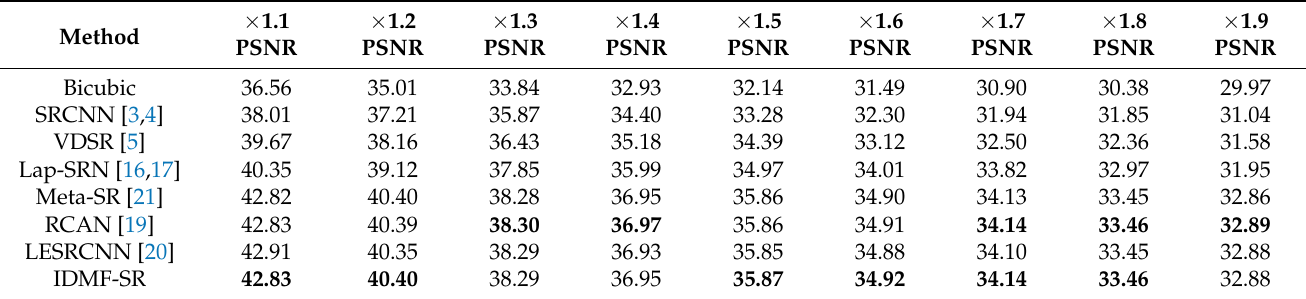
Table 2. The PSNR value of IDMF-SR under non-integer upscale factors.